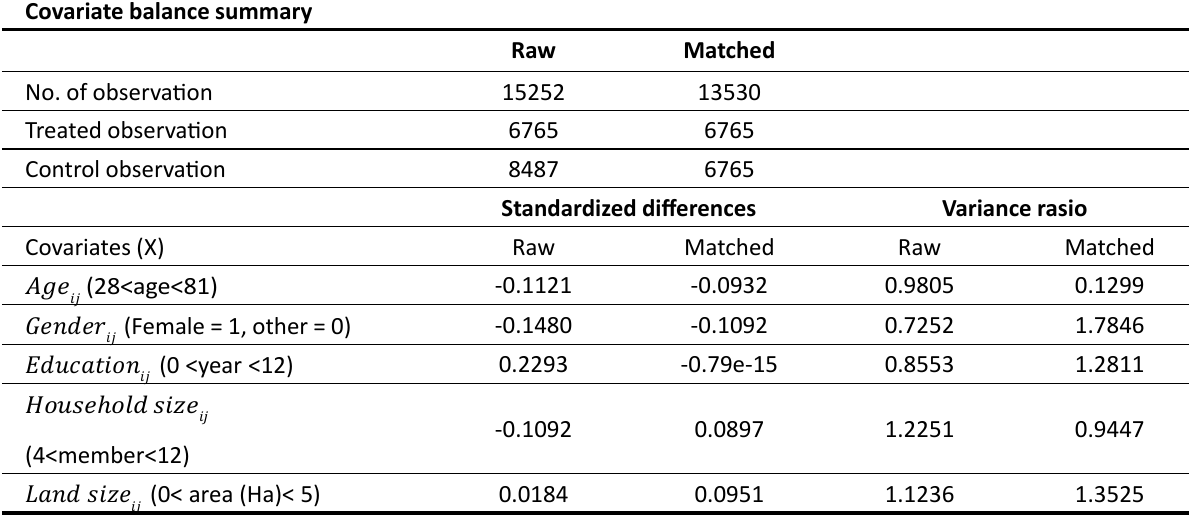
Table 6: Balancing Tests For Propensity Score Matching Using OD Data On Mutual Transac-